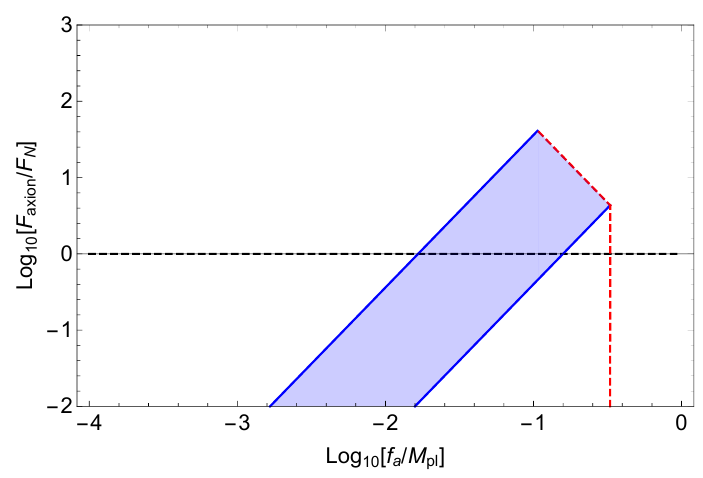
Figure 2 . The strength of the axion force between two neutron stars compared to the gravitational attraction as a function of the axion decay constant f a with a vanishing axion mass. The blue shaded region are regions of parameter space that are allowed after taking into account constraints on the neutron star equation of state. The upper and lower blue solid lines come from the maximal and minimal allowed neutron star radius-mass-ratio, respectively. The red dashed line marks the maximal f a above which the neutron star is not dense enough for our e(cid:11)ect to take